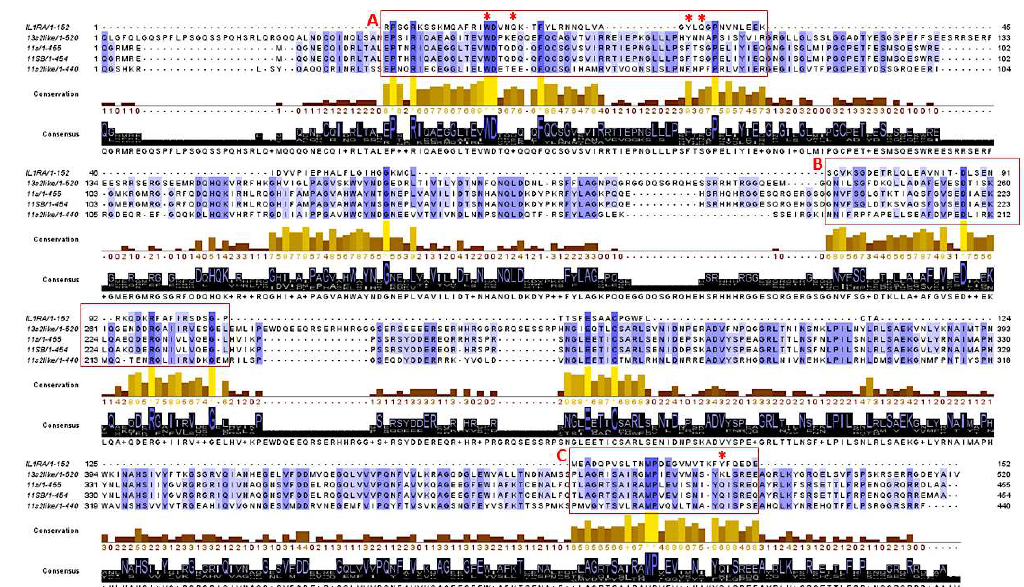
Figure 6. Alignment performed with the sequences of the mature form (without signal peptides) of IL-1RA (P18510) and the studied chenopodin isoforms. Sequence coloring represents percentage of identity; conservation and consensus logos are shown. Regions with the highest homology are represented into boxes (A, B, and C), and amino acids crucial for IL1-RA interaction with IL-1R are marked with an asterisk. The acronyms of chenopodin sequences are those reported in Table 1.